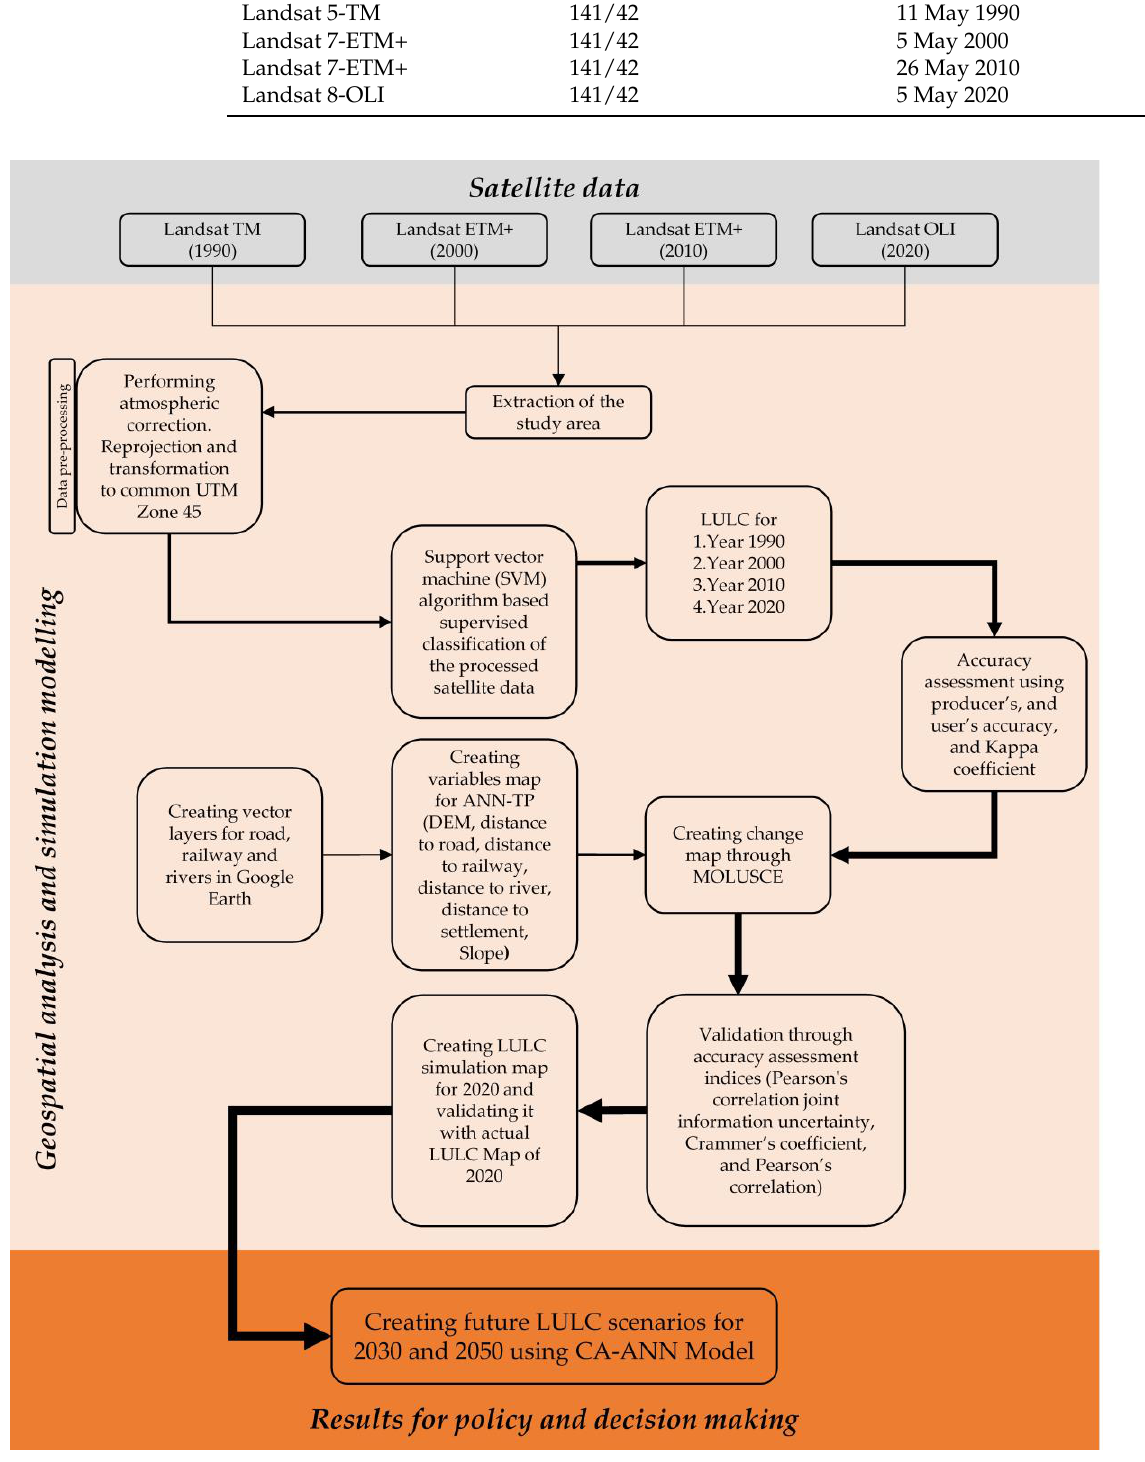
Figure 2. Methodology flowchart. The weight of the arrows reflects the stage of analysis.